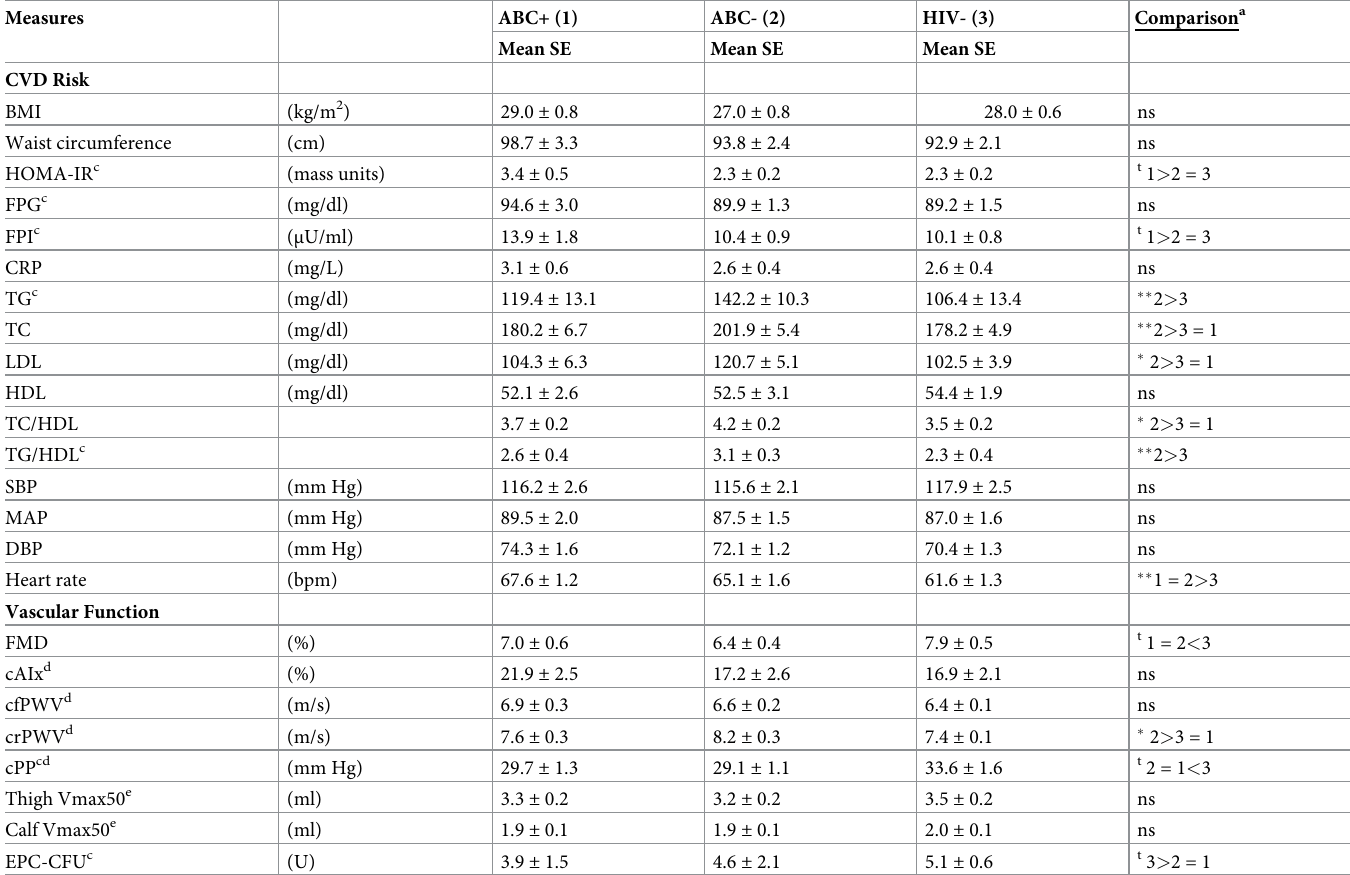
Table 3. Subclinical cardiometabolic measures comparing study groups.